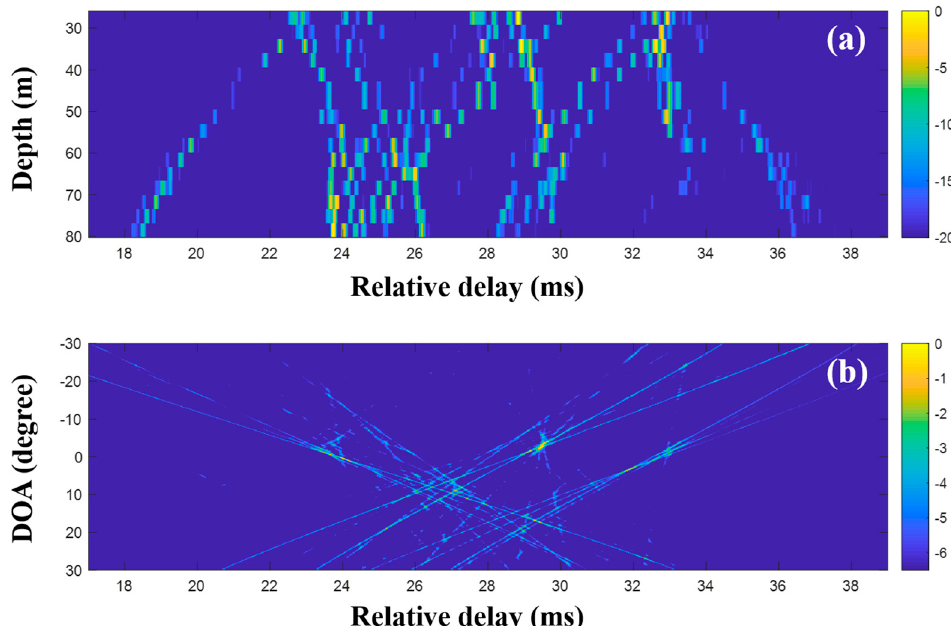
Figure 16. Direction-of-arrival (DOA) estimation using compressive sensing (CS) with multiple snapshots captured by the vertical line array (VLA) in SAVEX15 (11–31 kHz): ( a ) arrival structures via sequential CS usage applied to the signals at the VLA and ( b ) DOAs using delay-and-sum beamforming with the arrival structures.